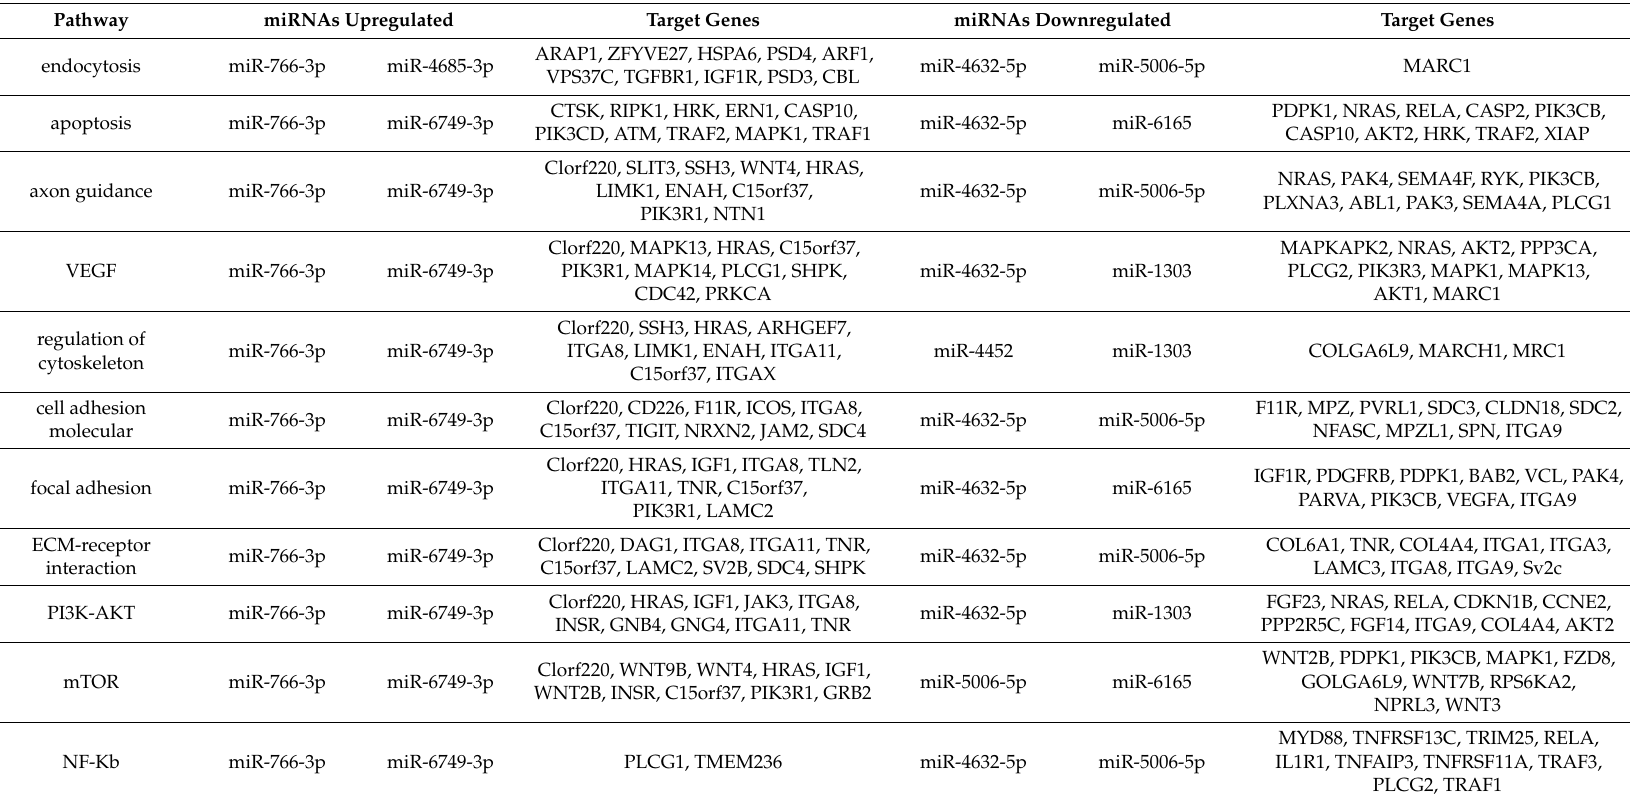
Table 4. Intervertebral disc (IVD) degeneration-related miRNA-target gene pathway